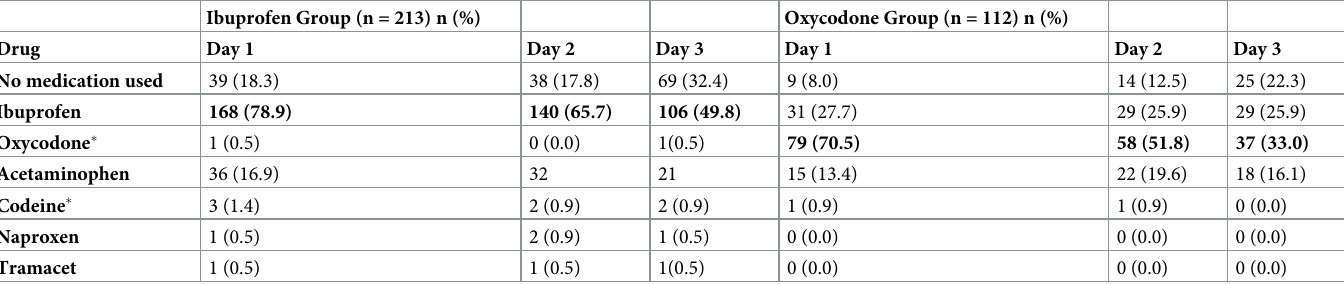
Table 2. At-home pain